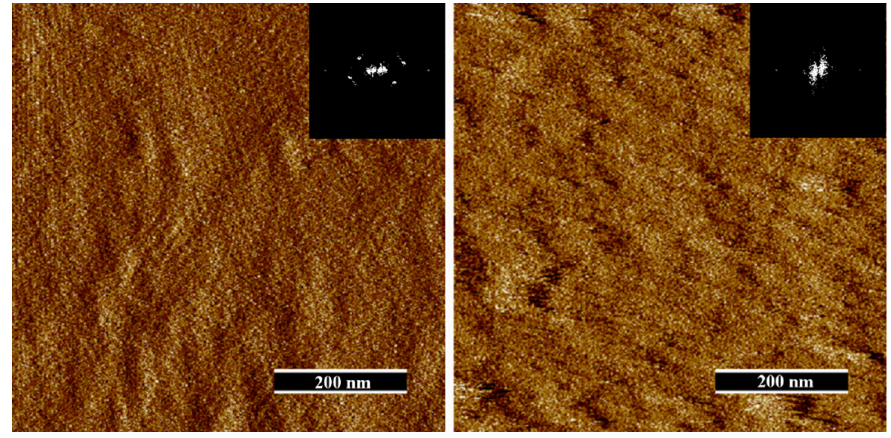
Figure A1. AFM height micrographs of SbpA films assembled in the presence of either CaCl 2 (left) or FeCl 3 (right), which act as positive or negative control images, respectively. Insets show the resulting Fourier spectra analysis from the respective images. Scale bars = 200 nm.